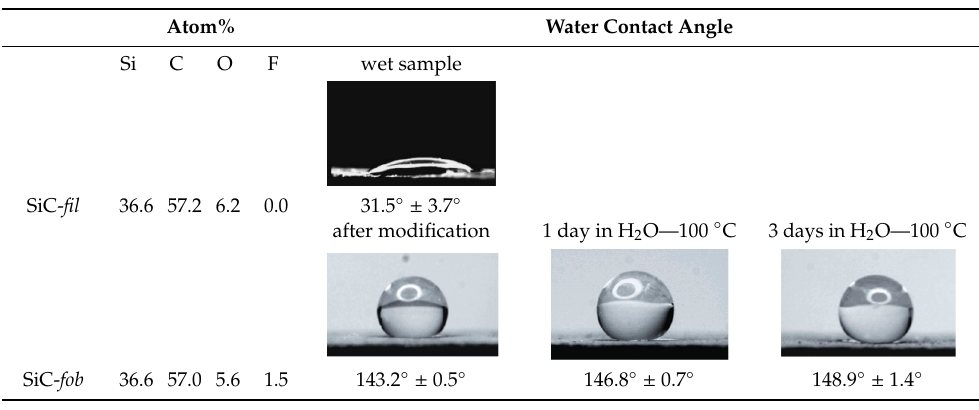
Table 1. EDX analysis and contact angle of water droplets for a flat-sheet membrane, measured before (SiC- fil ) and after modification (SiC- fob ). Contact angle measurements were repeated after soaking the modified membranes in boiling water for one day and three days.